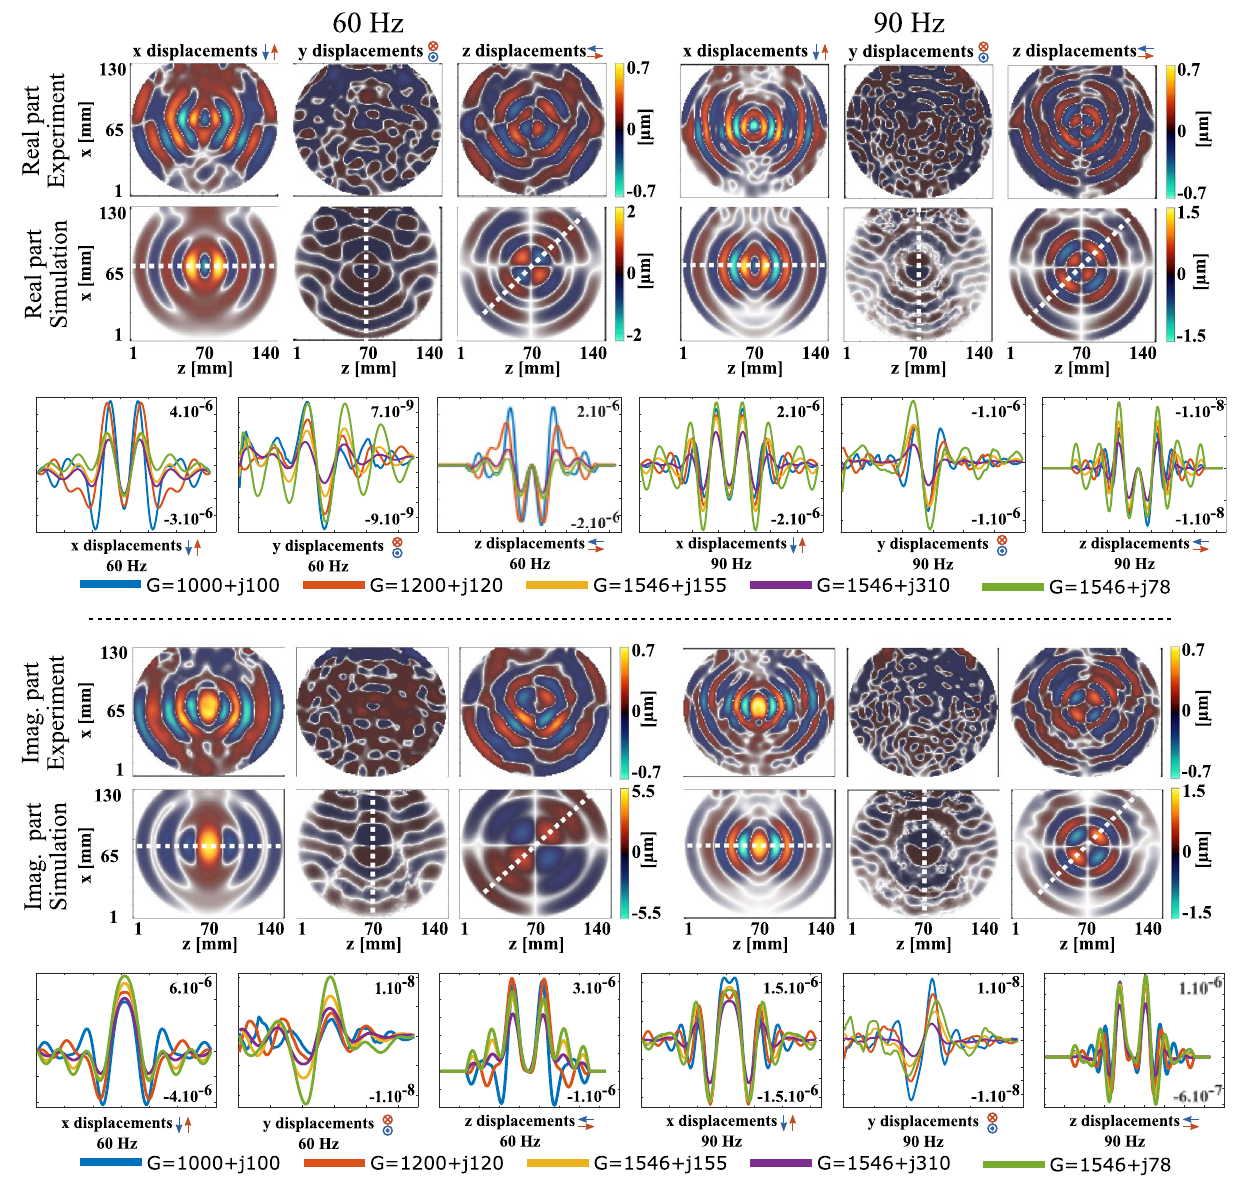
Figure 3. First experiment: Real and imaginary parts of the experimental and simulated complex displacement fields in phantom A along x, y, and z directions in the MR slice. The origin of elastic waves clearly appears at the centre of displacement maps. Images were acquired (experiment) and extracted (simulation) in the greyed-out sagittal plane located at the centre of the phantom, as indicated in Fig. 1 (“imaging plane” label). Two electrical currents were used with frequencies of 60 Hz and 90 Hz, and an intensity of 137.5 mA peak-to-peak in both experiment and simulation. The complex shear moduli used to obtain the displayed simulated displacement maps were: G 60Hz = 1546 + j155 Pa and G 90 Hz = 1768 + j177 Pa. Line profiles of the real and imaginary parts of displacements along the propagation directions (dashed white line) are plotted for each combination of storage and loss moduli described in Table 2. From these line profiles appear the diffraction patterns characteristic of body force actuation regardless of the complex shear